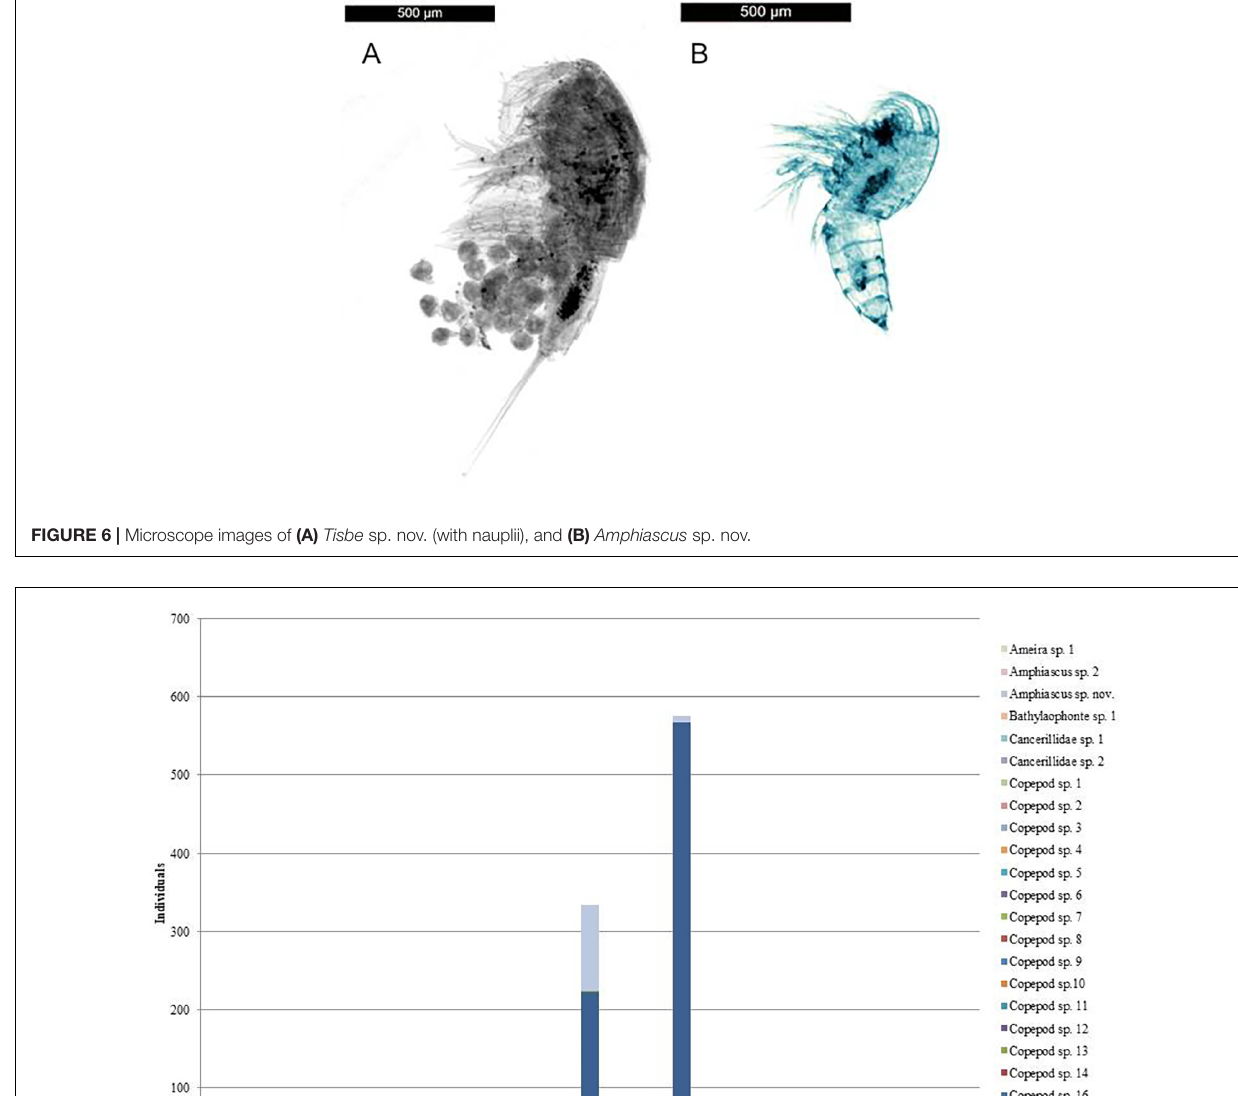
the total number of specimens from these samples. Both families were also recorded from ROV, EBS and vV samples regarded as not hydrothermally influenced, but in far less quantities. Identification of specimens belonging to the two dominating families in hydrothermally influenced samples indicates that both families were represented by only a single species each, Capitella Blainville, 1828 sp. (Capitellidae) and Mammiphitime Orensanz, 1990 sp. (Dorvilleidae), both putative new to science ( Figure 10